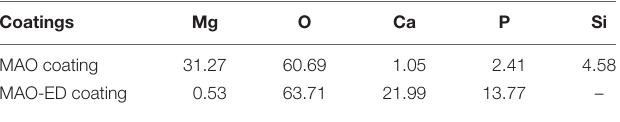
TABLE 3 | Element contents of the coatings on ZK60 Mg alloys derived from EDS analysis (at%). Coatings Mg O Ca P Si MAO